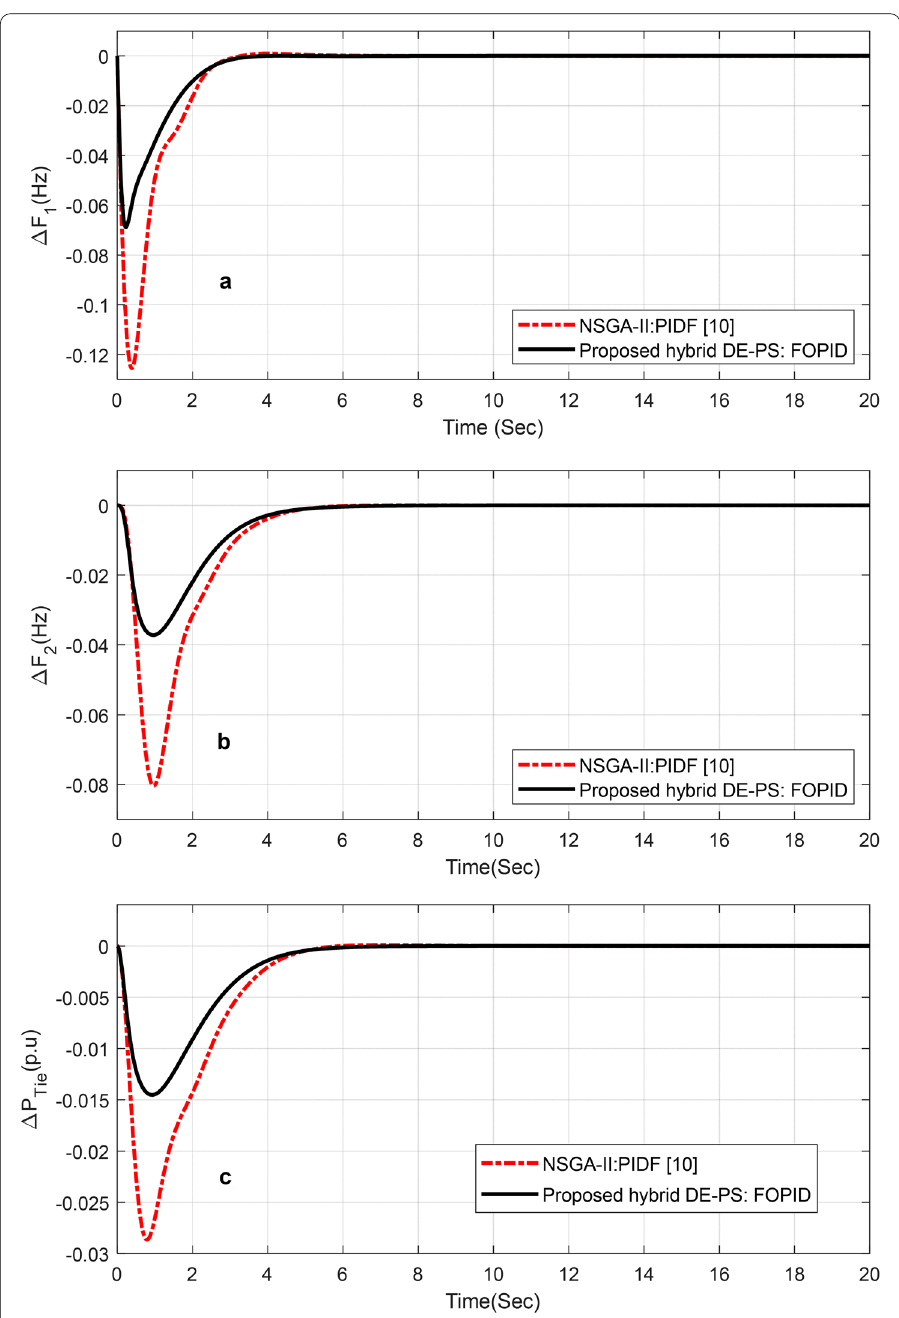
Fig. 10 System response for test system-II (� P D 1 = 0.1 p . u . MW & � P D 2 = 0 ) . a ΔF 1 b ΔF 2 c ΔP